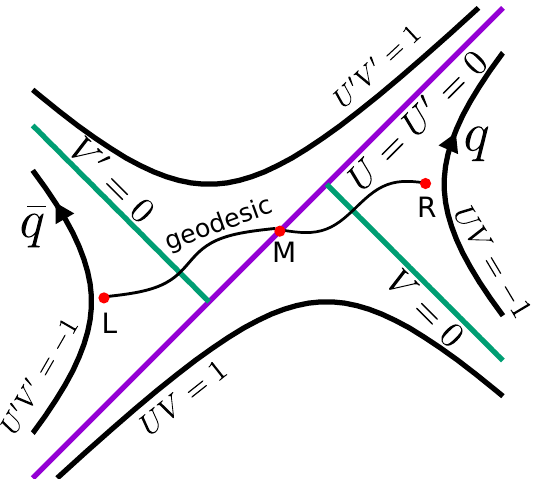
Figure 3. Spacetime structure of the perturbed string worldsheet. There is the shift γ in origins of ( U, V )- and ( U ′ , V ′